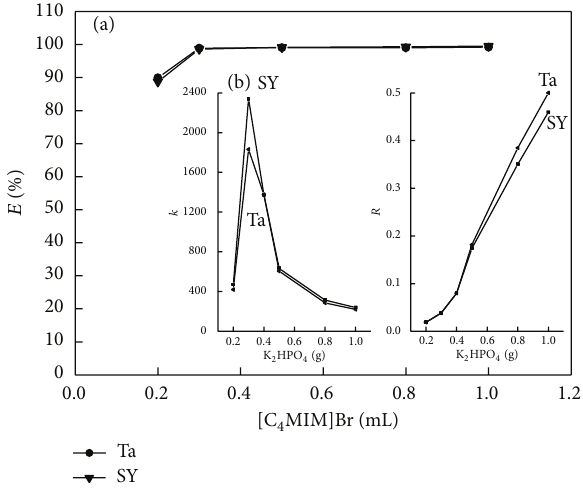
= Figure 4: Effects of [ C 𝑛 MIM ] Br amount on extraction efficiency, SY partition coefficient, and phase ratio ( 𝑚 = 3.0 𝑚 K 2 HPO 4